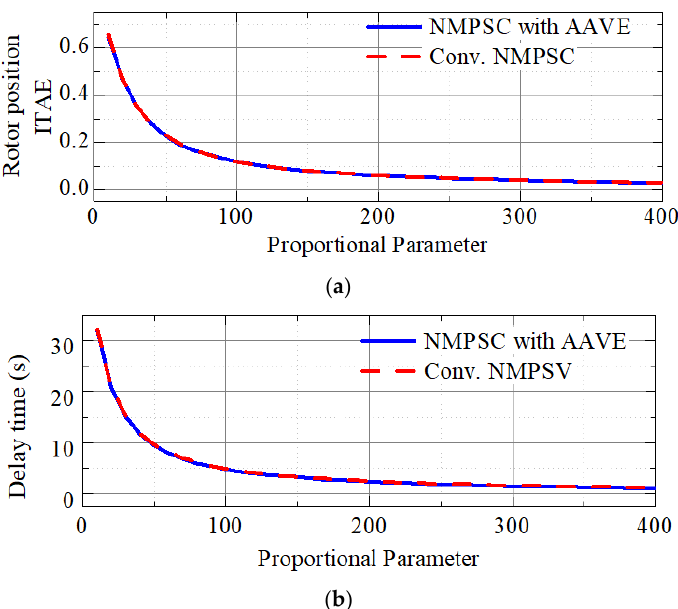
Figure 9. Performances for different proportional parameter values. ( a ) Rotor position ITAE; ( b ) Delay time.